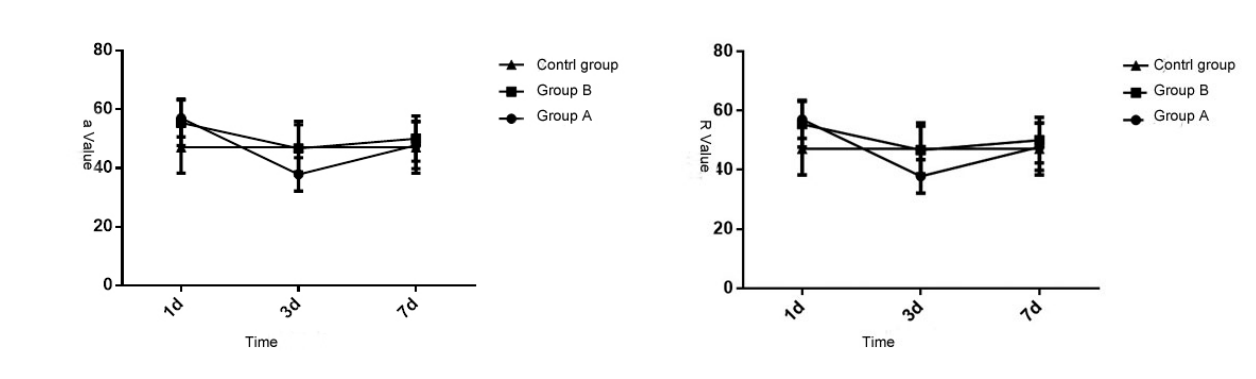
Table 3: Variance analysis of α value of the patients in the three groups at different times